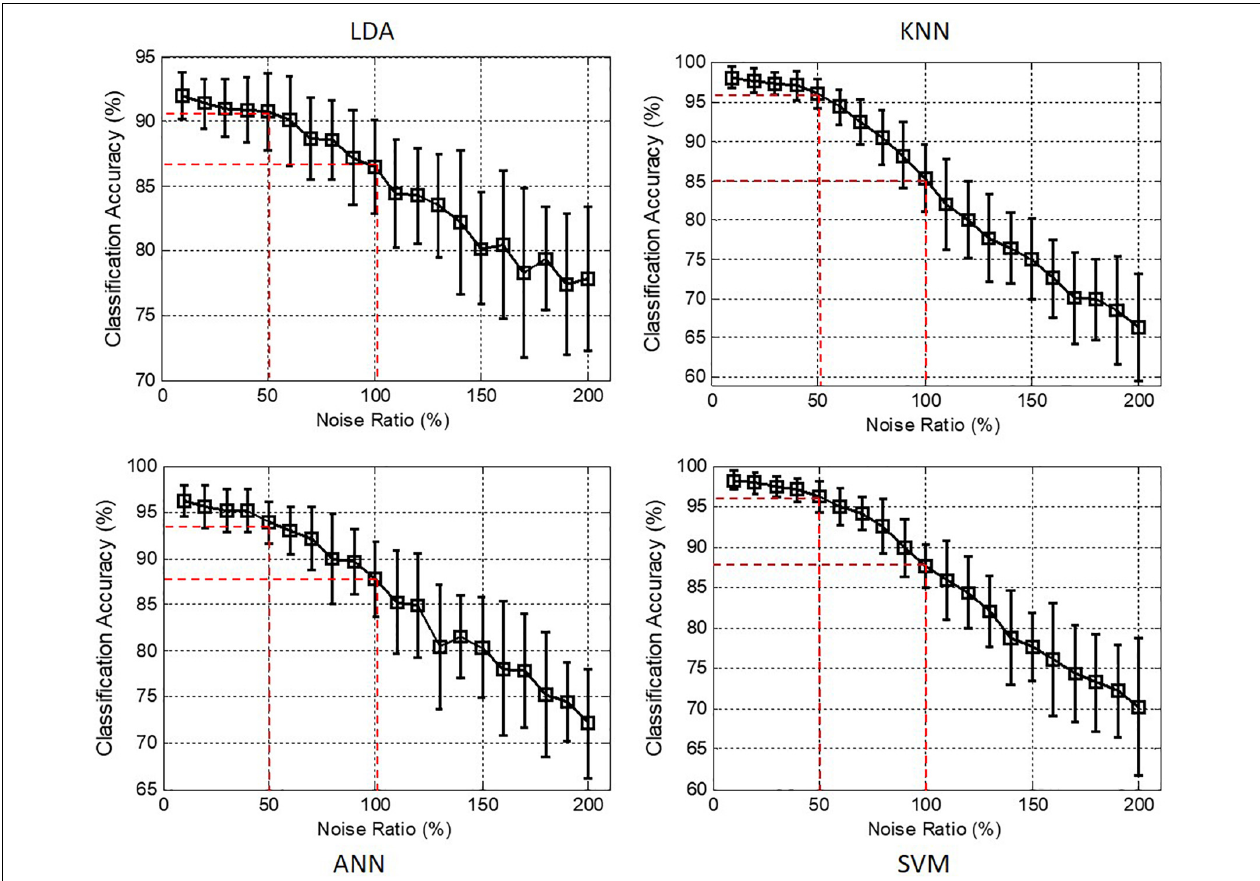
FIGURE 10 | Classification accuracies achieved by the optimal feature combinations for LDA, KNN, ANN, and SVM classifiers when RSC signals were contaminated with whiten